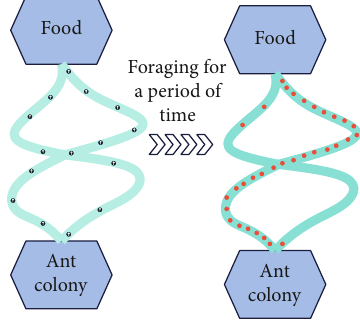
Figure 5: Foraging process of ant